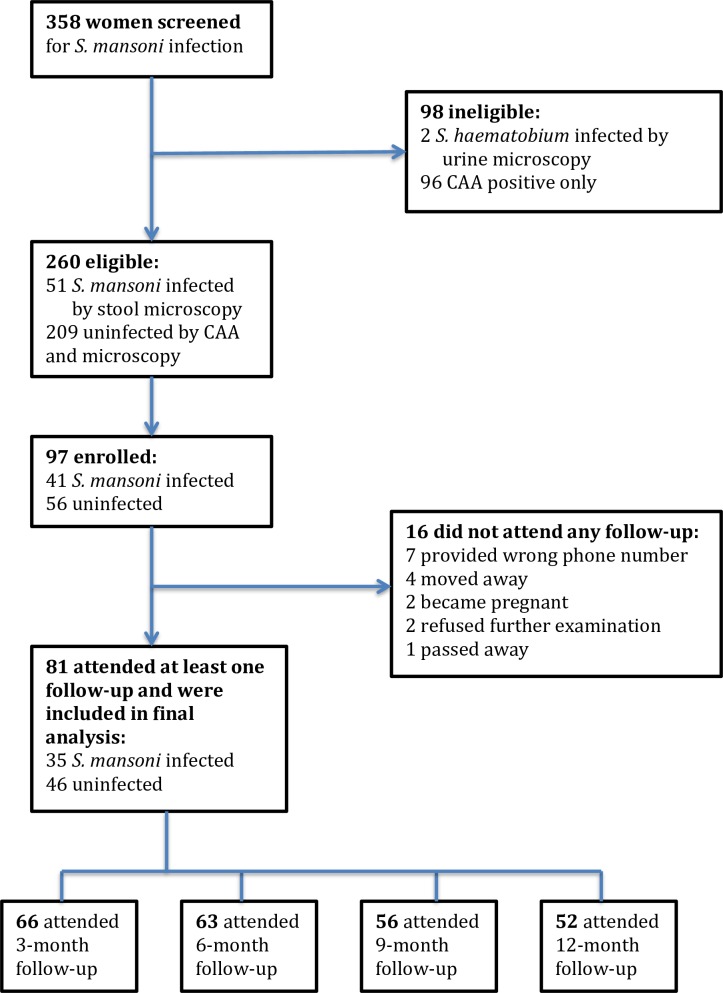
Flow chart of study screening and enrollment.